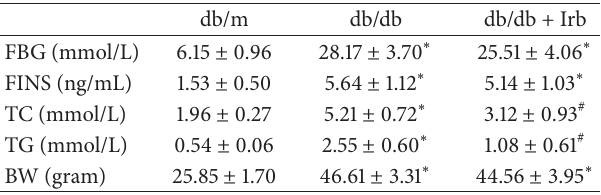
Table 1: Animal characteristics at the end of the